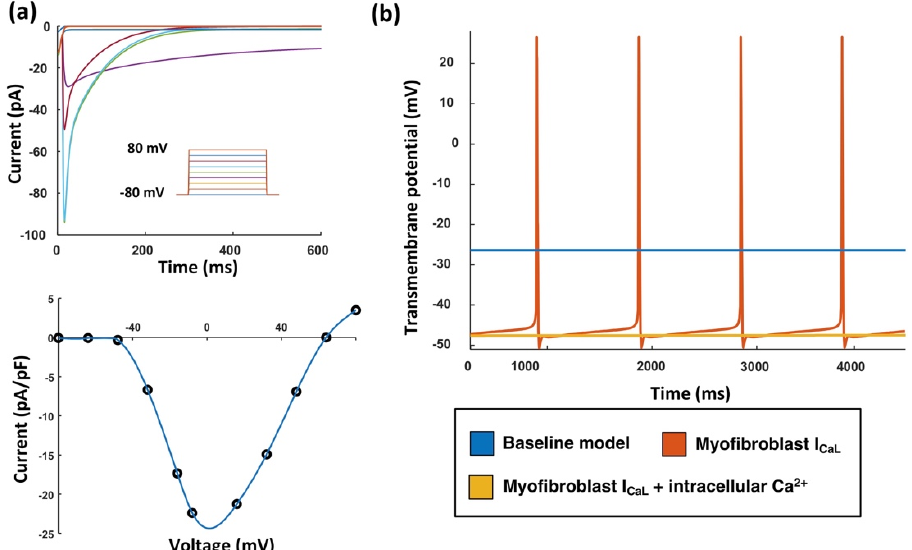
Figure 3. Myofibroblast electrophysiology including the I CaL current and the intracellular Ca 2+ handling system. ( a ) In silico patch-clamp experiment for I CaL (top) and comparison (bottom) with in vitro data (dots) from [11]. ( b ) Transmembrane potential of three different non-paced models: baseline model (blue), myofibroblast with I CaL (red), and myofibroblast with I CaL and intracellular Ca 2+ handling (yellow).